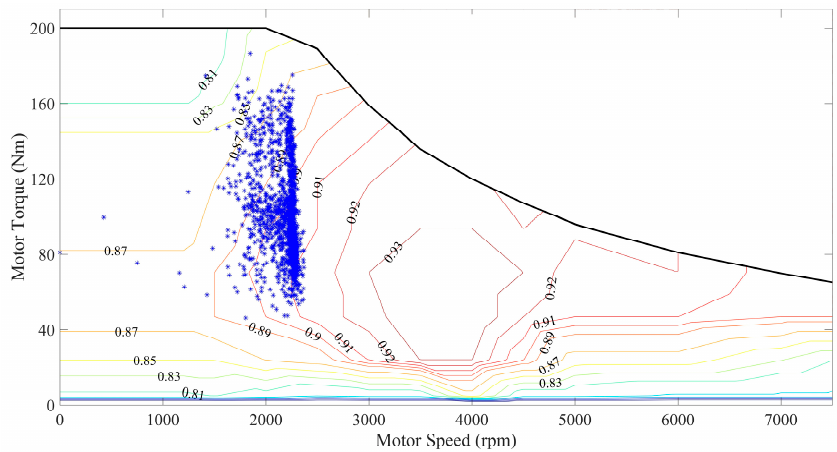
Figure 17. Working points of EM_T in the SMPS under rotary tillage cycle.